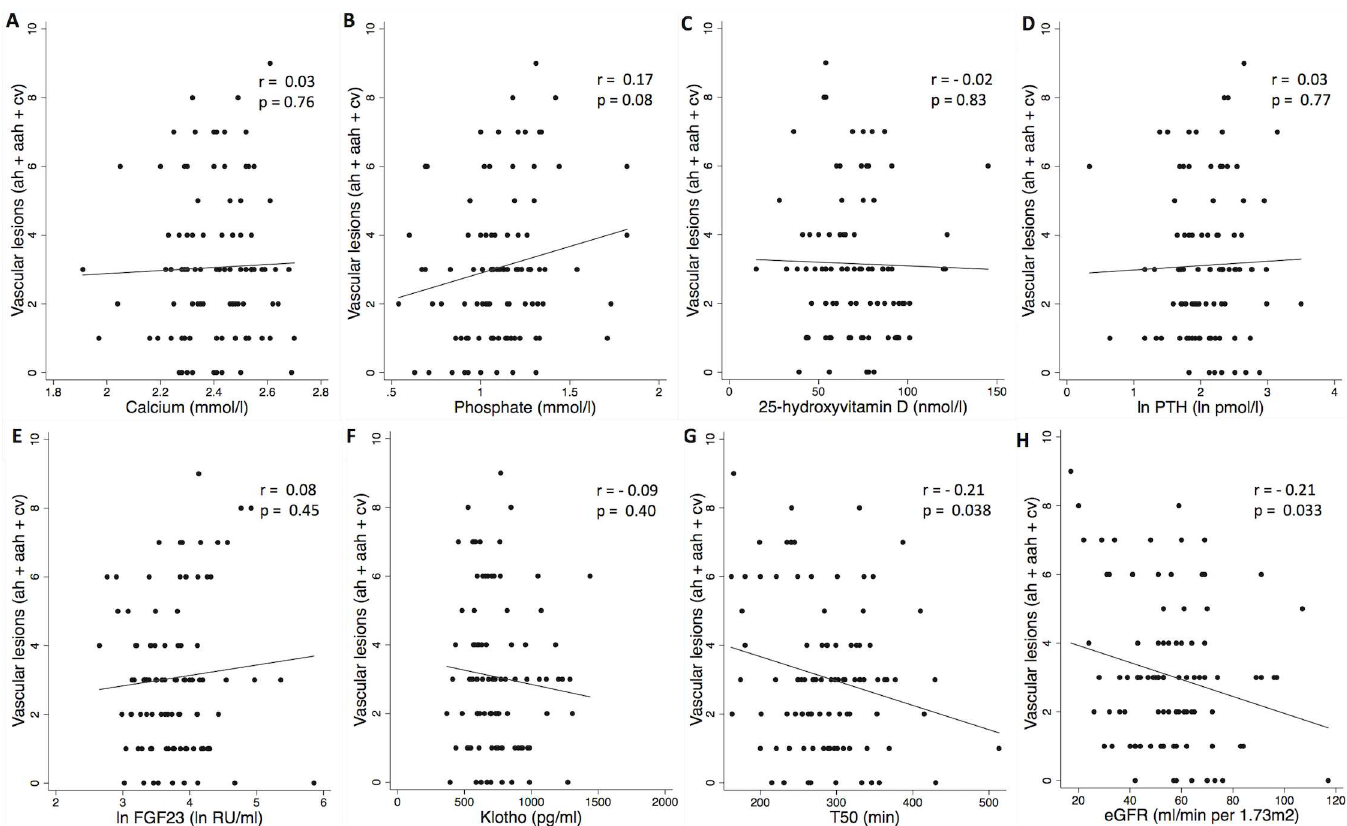
Fig 4. Phosphocalcic biomarkers and T 50 associatewith chronic vascularlesions as assessedby banff (ah+aah+cv) in renal allograft recipients. Scatter plot graphs of (A) calcium, (B) phosphate, (C) vitamin D, (D) ln PTH, (E) ln FGF23, (F) Klotho, (G) T 50, (H) eGFR versus vascular lesions. Each symbol representsone patient. The continuousline indicates least-square linear regression.Ah: arteriolar hyalinethickening; aah: circumferential hyalinearteriolar thickening; cv: vascular fibrous intimal thickening; eGFR: estimated GlomerularFiltration Rate; Ln: log-transformed; PTH: parathyroidhormone; T 50 : Calcification propensity.